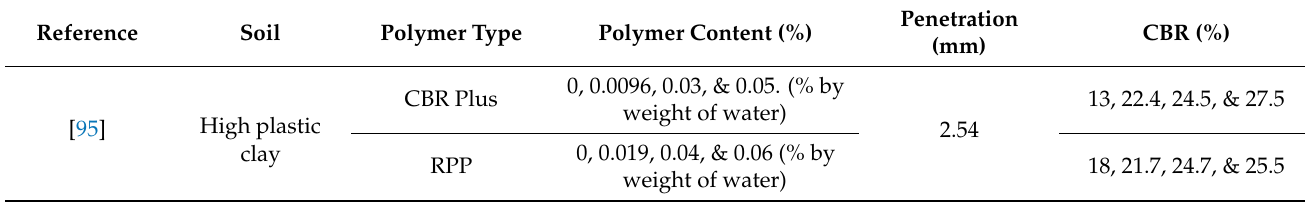
Table 2. The effect of various polymer on